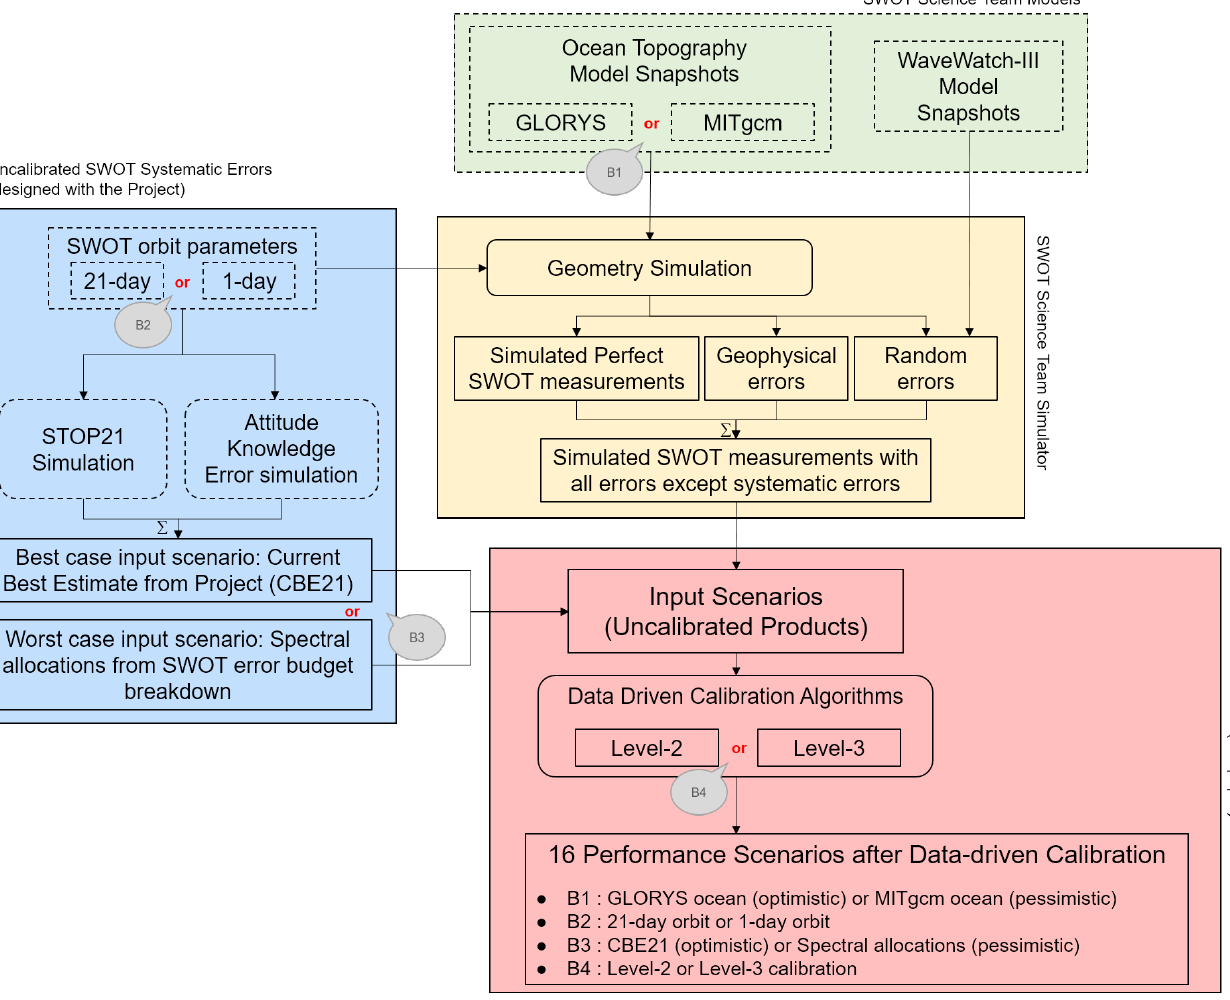
Figure 3. Overview of our end-to-end simulation scheme. The data-driven algorithm and simulations presented in this paper are in the red box. They use two inputs: a simulation of SWOT productions without systematic errors (output of the yellow bow) and a simulation of the uncalibrated systematic errors (output of the blue box). The four simulations branches B1 to B4 combine into 16 possible scenarios. Dashed boxes were provided by the SWOT Project (blue) or other members of the SWOT Science team (green).